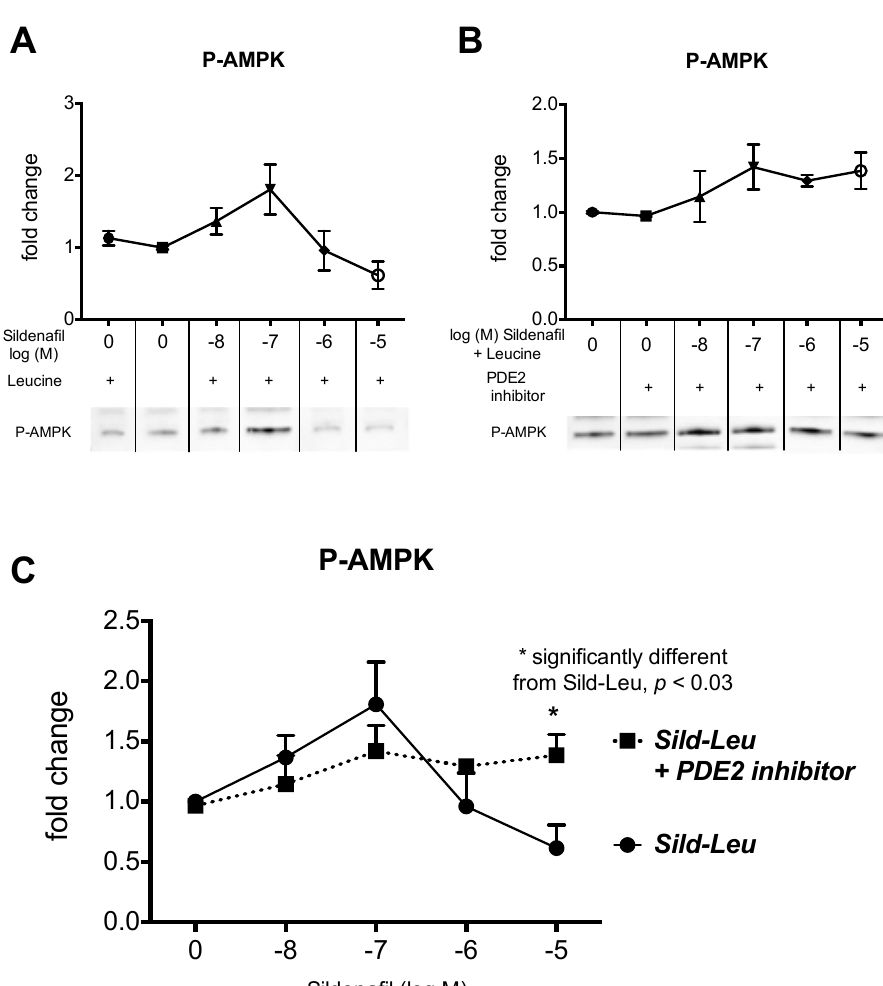
Figure 3. Protein expression of Phospho (Thr172)-AMPK in HepG2 cells. Protein expression of Phospho (Thr172)-AMPK in HepG2 cells treated with a fixed dose of leucine (0.5 mM) in combination with ( A ) sildenafil (10 nM to 10 µM) or ( B ) sildenafil (10 nM to 10 µM) plus the PDE2 Inhibitor (BAY 60-7550, 10 uM) for 24 h. Graphs were calculated from pooled densitometry measurements of two different blots ( n = 3 to 4) and representative blots are shown. ( C ) Comparison of P-AMPK response to Sildenafil-Leucine for the addition of the PDE2 inhibitor. * indicates a significant difference between the curves ( p < 0.03).